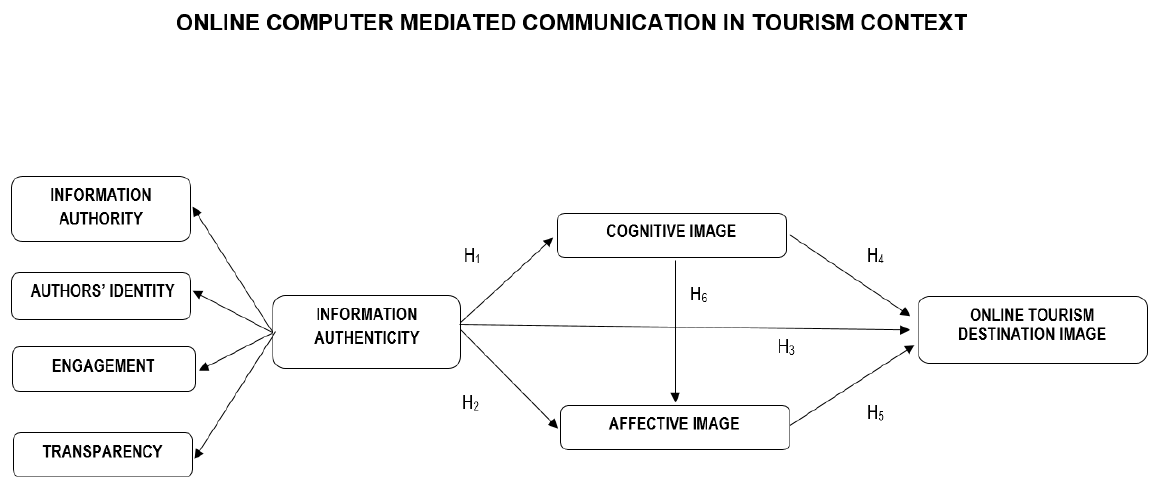
Figure 1. Research